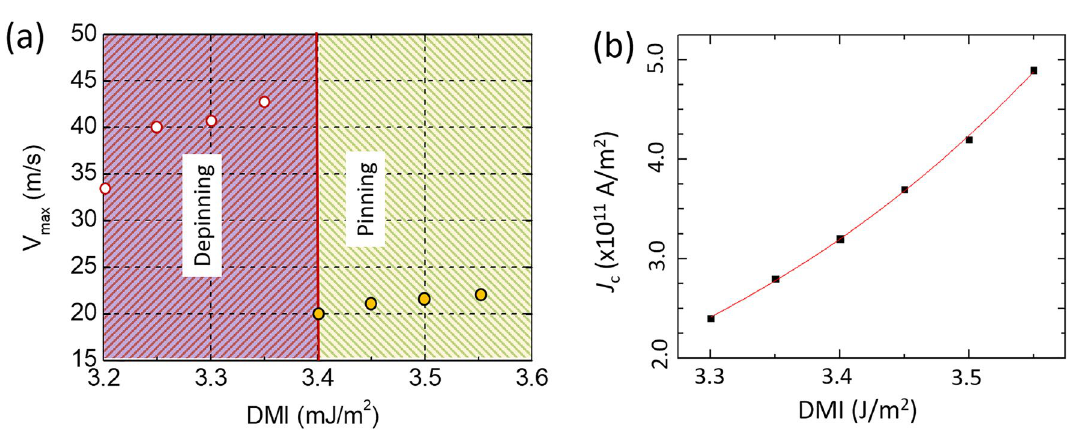
Figure 7. ( a ) The maximum velocity of the skyrmion in a stepped nanowire versus DMI. High DMI favours the pinning of the skyrmion while it is easier to release it from the stepped region at lower DMI. In both